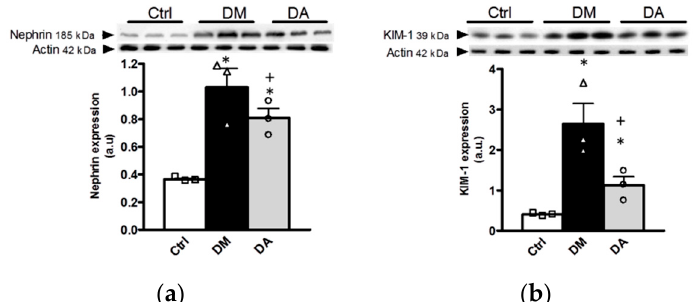
Figure 3. Effects of allicin on glomerular and tubular markers of kidney injury in cortex. ( a ) Nephrin and ( b ) kidney injury molecule-1 (KIM-1). Ctrl: control; DM: diabetes; DA: diabetes treated with allicin; a.u: arbitrary units. For representative Western blotting, 3 randomly selected samples per group were analyzed. Results are presented as mean ± SEM and analyzed by one-way ANOVA. Statistical significance was established as * p < 0.05 vs. Ctrl, + p < 0.05 vs. DM.